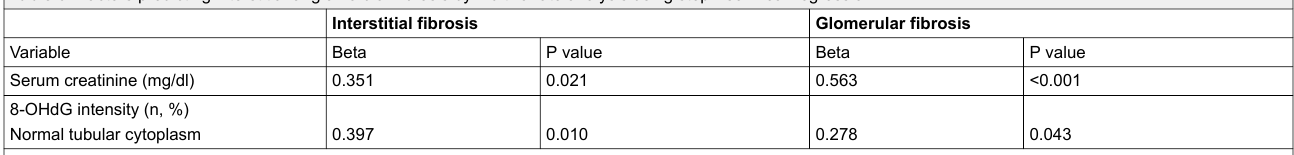
Table 5: Factors predicting interstitial or glomerular fibrosis by multivariate analysis using stepwise linear regression. Interstitial